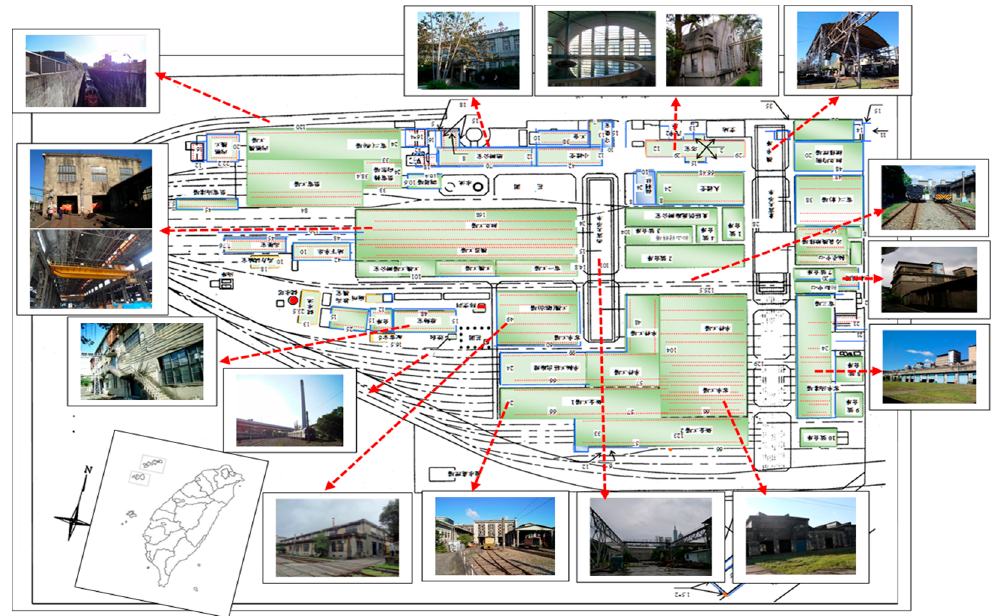
Figure 4. Taipei Railway Work’s rail cultural heritage landscape (source: adapted from Taiwan Railway Administration (TRA)).